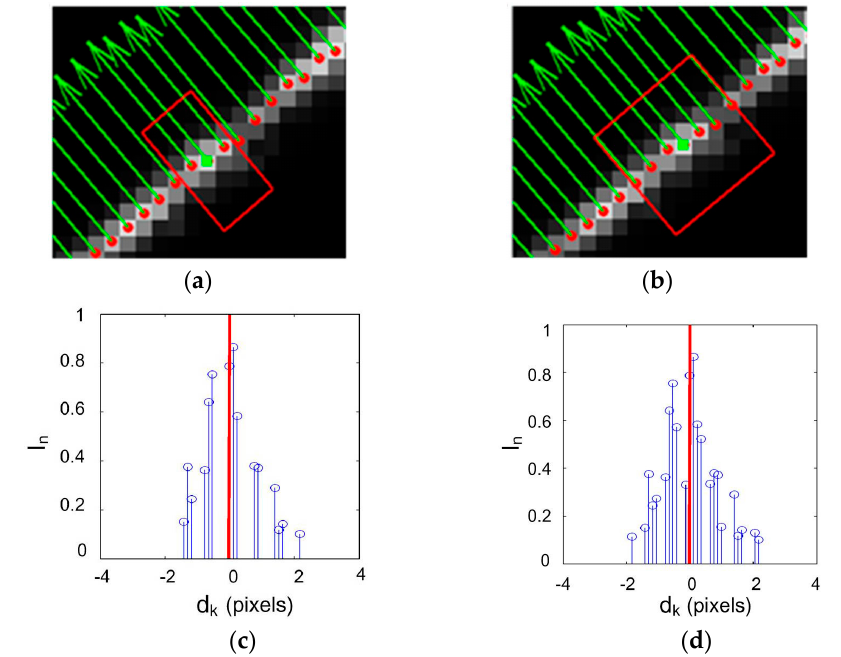
Figure 4. Center computation within a specific rectangular region: ( a ) rectangular region with w j = 4; ( b ) rectangular region with w j = 9; ( c ) pixels for the center computation of ( a ); ( d ) pixels for the center computation of ( b ).